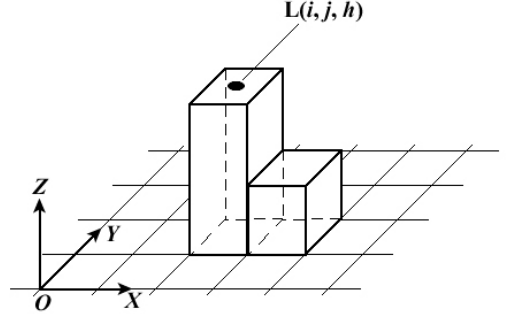
Figure 7. Constructions of solutions